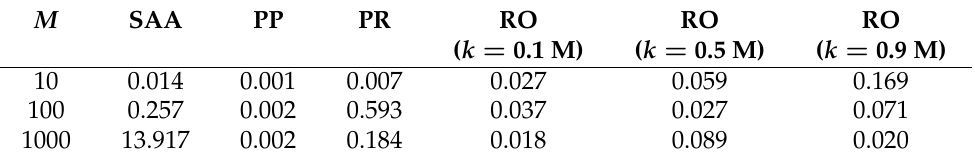
Table 5. Average CPU Time to solve randomly generated